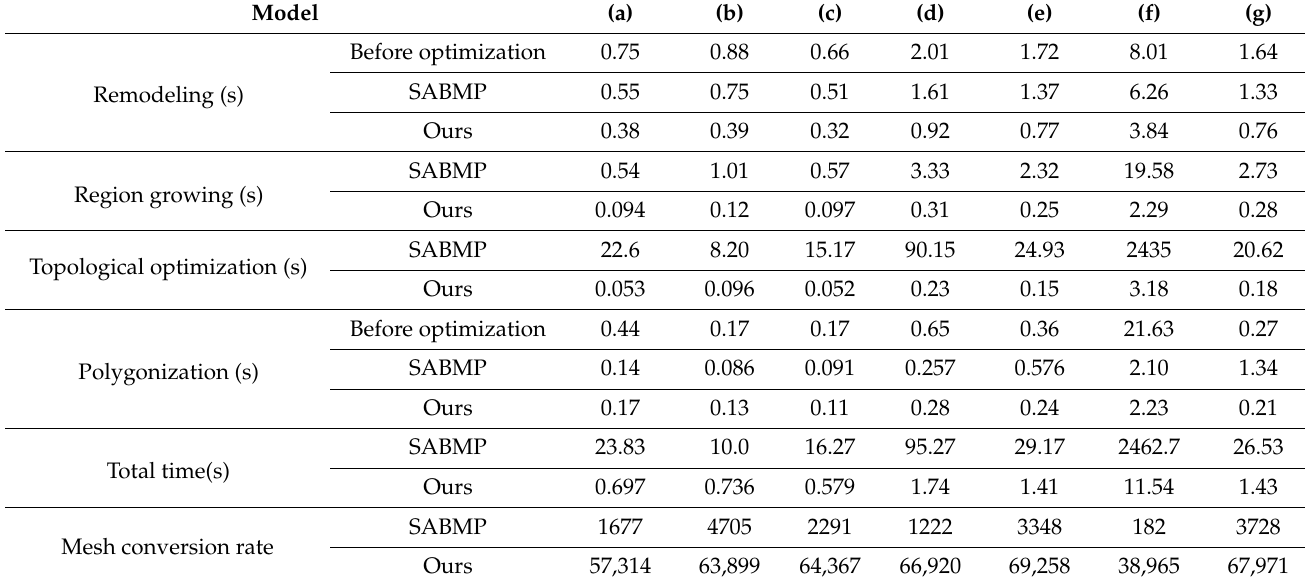
Table 2. Comparison of running time of each